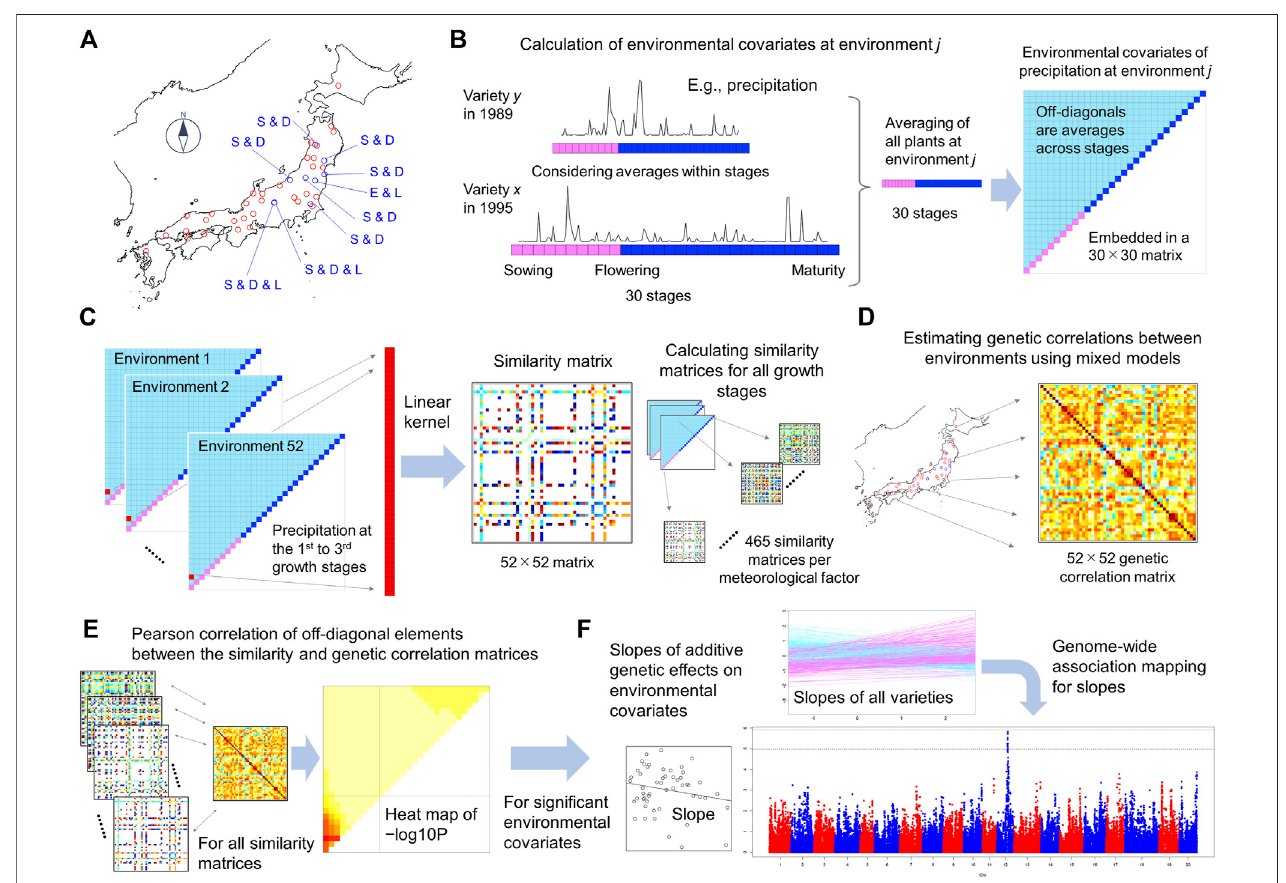
FIGURE 1 | Illustration of the framework of ECGC. (A) Forty-one fi elds and 52 environments were analysed in this study. The blue points indicate fi elds where multiple management conditions were regarded asdifferentenvironments. Eand L denote early and late sowing, and D and Sdenote dense and sparse plantdensities, respectively. (B) Calculation ofenvironmentalcovariates representing each environment. Precipitation isillustrated asameteorologicalfactor. Thewholegrowth periods of plants were divided into 30 stages (10 from sowing to fl owering and 20 from fl owering to maturity), and the meteorological values within each stage were averaged.Theseaveragedvalueswereagainaveragedacrossallplantsat theenvironment, thuscreating 30environmentalcovariates (redandblue boxesintheupper- right triangle). The environmental covariates were then averaged across all spans within the 30 stages (1st to 2nd stages, 1st to 3rd stages, etc.), thus generating 435 additional covariates (pale-blue boxes in the triangle). In total, 465 (30 + 435) environmental covariates for each trait-meteorological factor combination were generated. Because 14 meteorological factors were considered, 465 × 14 (cid:2) 6,510 environmental covariates were generated for each trait. (C) Calculation of the similarity matrix of environmental covariates between environments. The fi gure illustrates the similarity matrix of precipitation at the 1st to 3rd growth stage, as an example. For each environmental covariate, values were extracted from the 52 environments and a 52 × 52 similarity matrix wascalculated using the linear kernel. (D) Estimation ofgenetic correlationsbetweenenvironments.Usingmixedmodelsandgenome-wideSNPs,geneticcorrelationswereestimatedforthe52environmentsinapairwisemanner (E) Calculation of the Pearson correlation coef fi cient ( r ) of off-diagonal elements between the similarity and genetic correlation matrices. r was calculated for all similarity matrices,and − log10 p valuesarepresentedasheatmaps. (F) Genome-wideassociationmappingforuncoveringgeneticarchitecture.Fortheenvironmentalcovariates signi fi cantly detected in (E) , slopes were estimated for each variety by regressing the additive genetic effects estimated using mixed models on the environmental covariates. Genome-wide association mapping was conducted on the